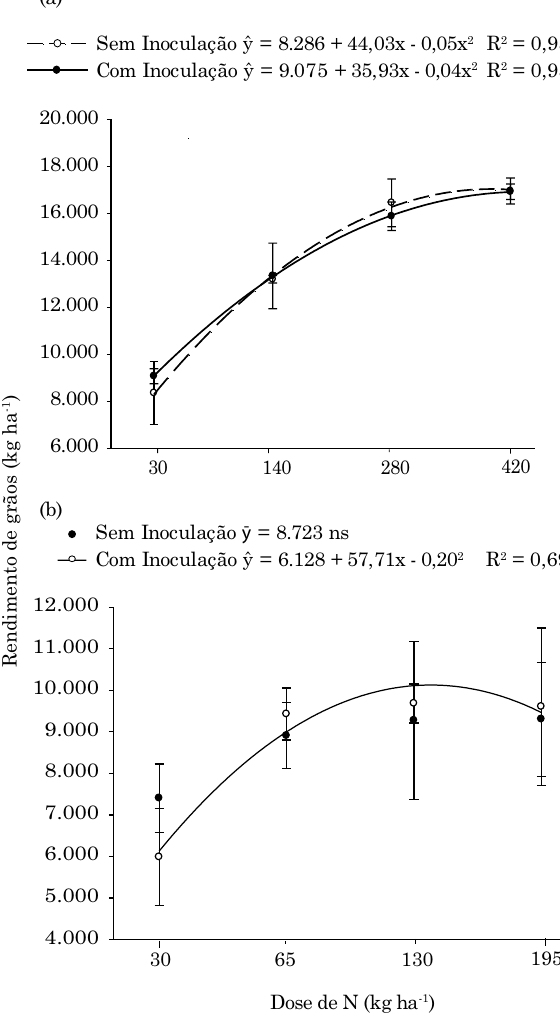
Figura 3. rendimento de grãos do milho em função de doses de nitrogênio, com e sem inoculação das sementes com Azospirillum , nos níveis de manejo alto (a) e médio (b), em lages, sc, durante os anos agrícolas de 2011/2012 e 2012/2013.